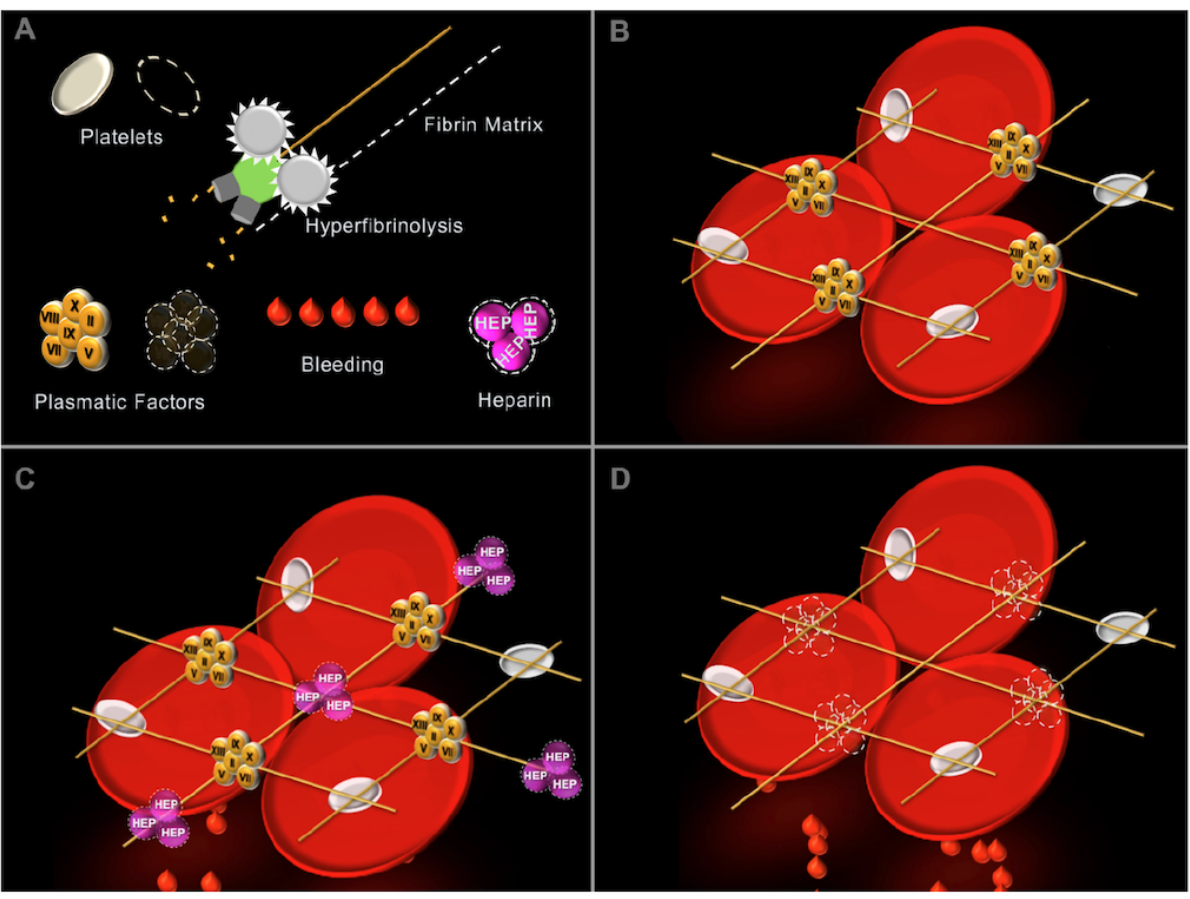
Figure 1. Graphics illustrating Visual Clot technology. A: The different coagulation components that Visual Clot represents as either present or absent (when dashed). B: A healthy Visual Clot with all coagulation elements present in sufficient quantity. C: A bleeding Visual Clot with heparin effect. D: A bleeding Visual Clot indicating the absence of plasmatic